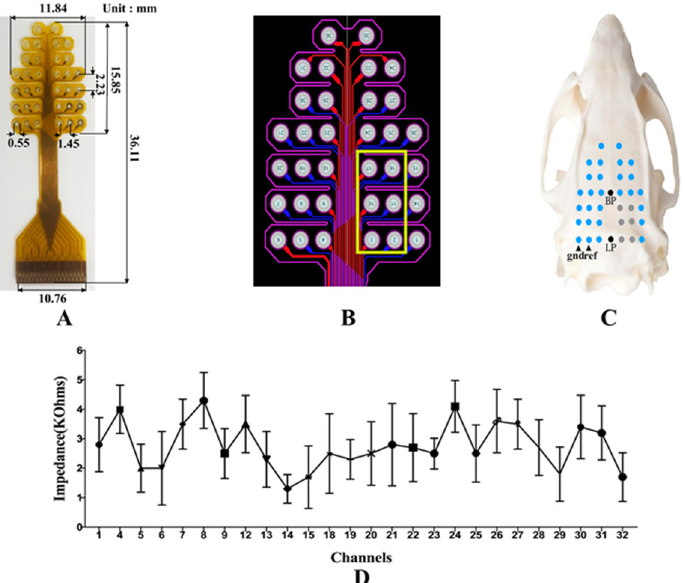
Figure 1. ( A ) Self-developed 32-channal EEG electrode and its size. ( B ) The electrode circuit diagram, the part inside the yellow box is the position reserved for the ultrasound transducer. ( C ) The relative position of the electrode on the skull surface. ( D ) Impedance of each channel of the electrode.